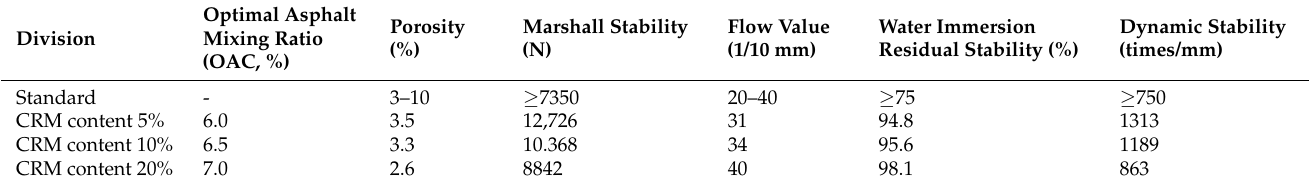
Table 6. Derivation of optimum asphalt mixing ratio and Marshall stability by CRM content.